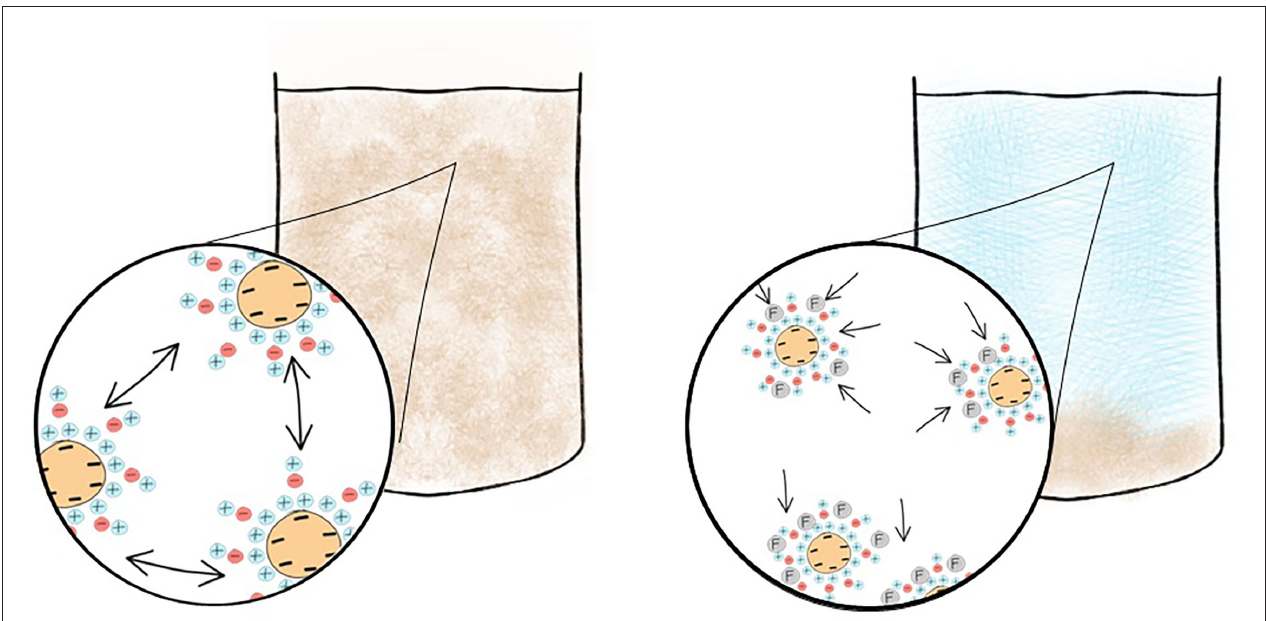
FIGURE 3 | Addition of a flocculant such as aluminum improves water clarity prior to public consumption. Colloidal suspensions persist when the particulate matter is too light to sink and their surrounding charge prevents the colloids from adhering to each other. The addition of a flocculant overcomes this causing the colloid to form flocs which will sediment within the body of water. Aluminum, a flocculant, is added to drinking water and now removed by reverse osmosis prior to use in dialysis preventing